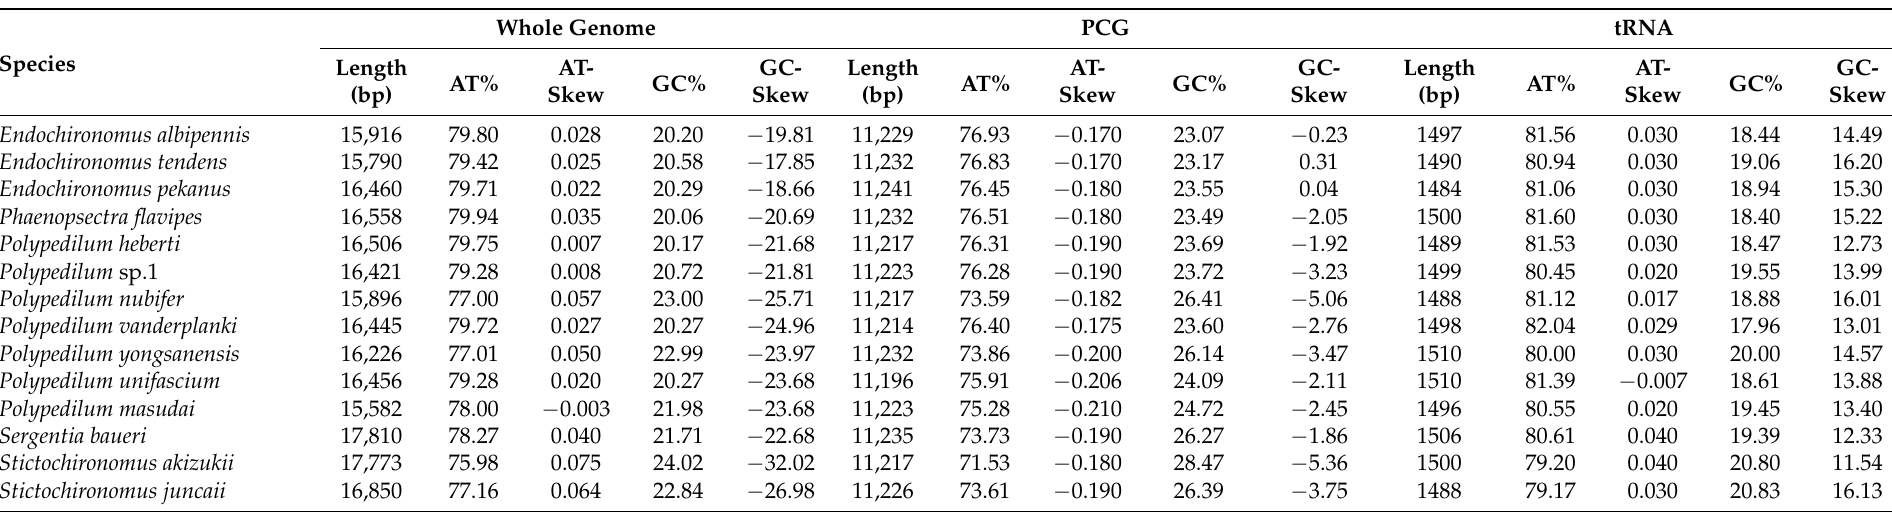
Table 2. Nucleotide composition of 19